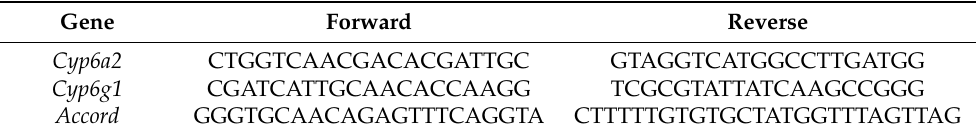
Table 1. PCR primers sequences.